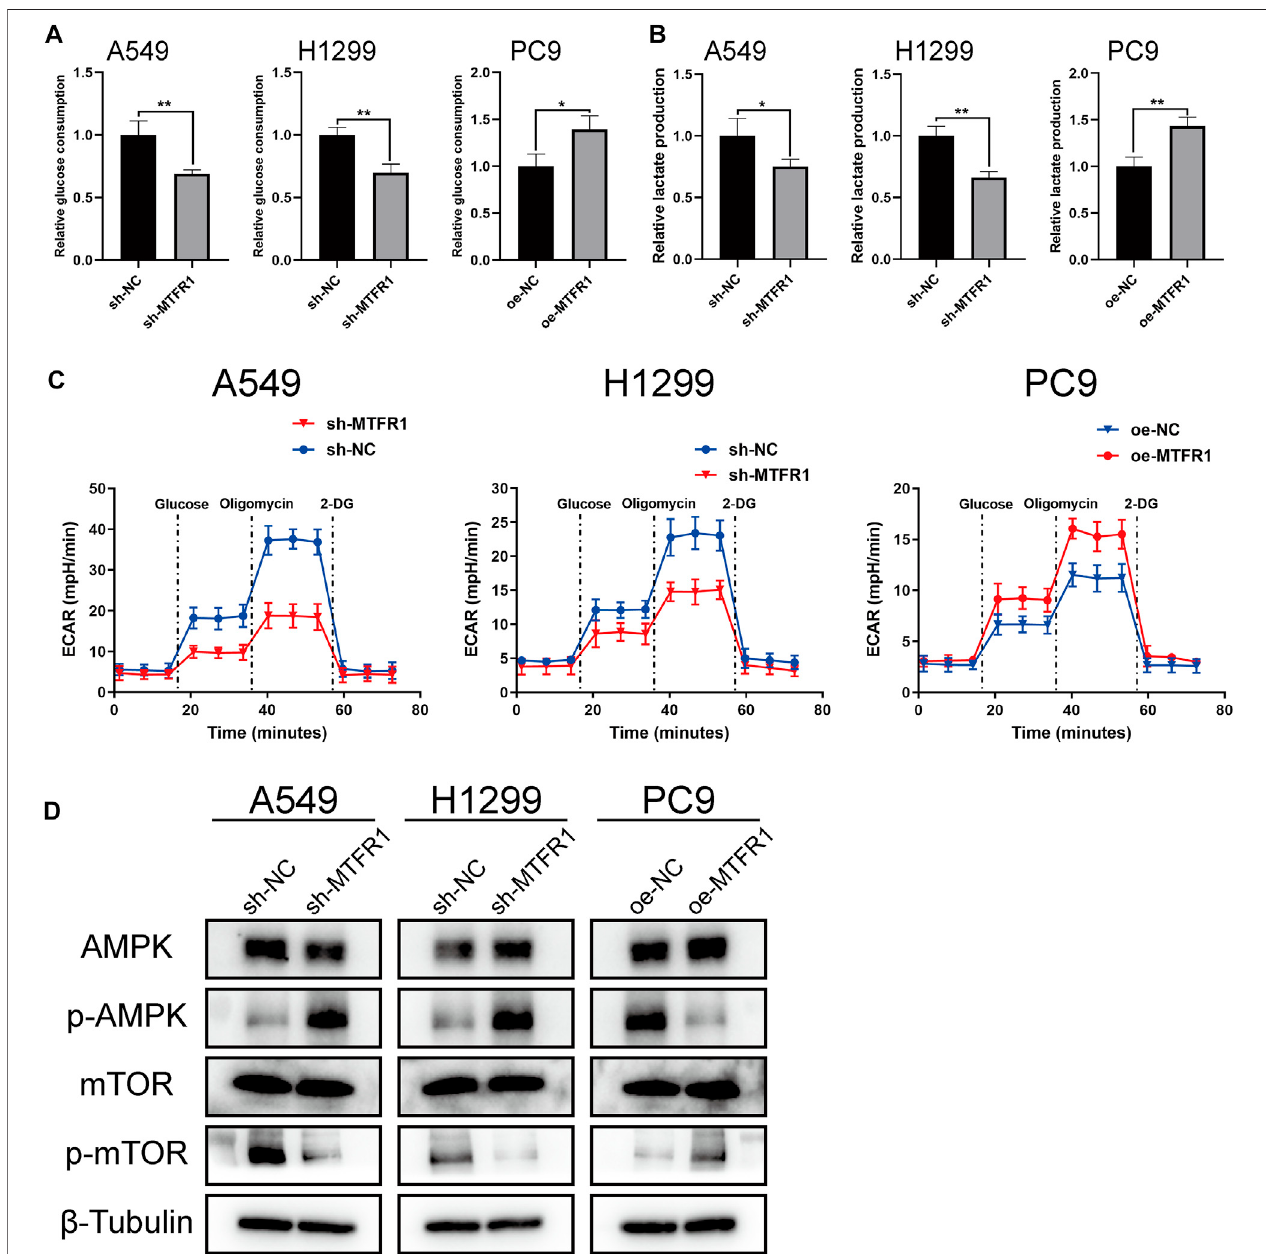
FIGURE5| MTFR1regulatedglycolysisandAMPK/mTORsignallingpathway inLUADcells. (A) Relativeglucoseconsumptionofthetransducedcells. (B) Relative lactateproduction ofthetransducedcells. (C) Relativeextracellularacidi fi cationrate(ECAR)ofthetransducedcells. (D) Evaluationoftheexpression ofAMPK,p-AMPK, mTOR, and p-mTOR in the transduced cells by WB. Data were articulated as the mean ± standard deviation (SD; * p < 0.05, ** p < 0.01).